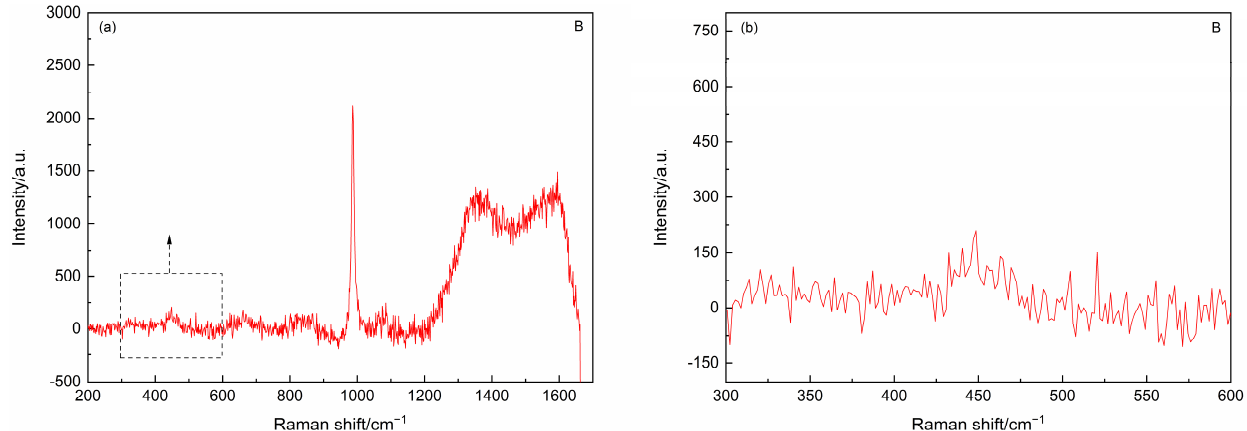
Figure 9. ( a ) Raman spectrum of the point B in Figure 7 after subtracting the background. ( b ) Inset of Raman spectrum in ( a ) in the range of 300–600 cm − 1